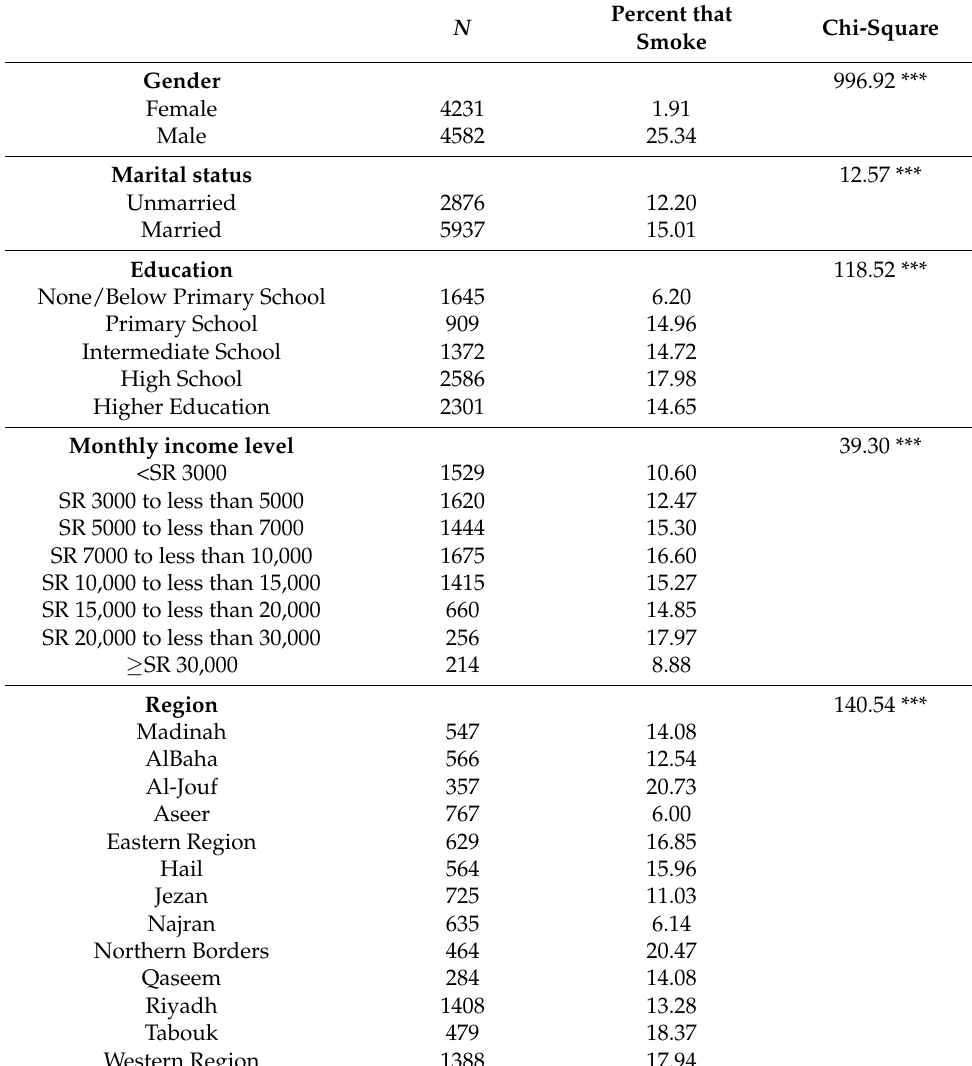
Table 2. Bivariate analysis of current smoking and categorical socioeconomic